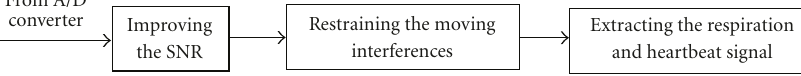
Figure 2: The basic flowchart of the signal